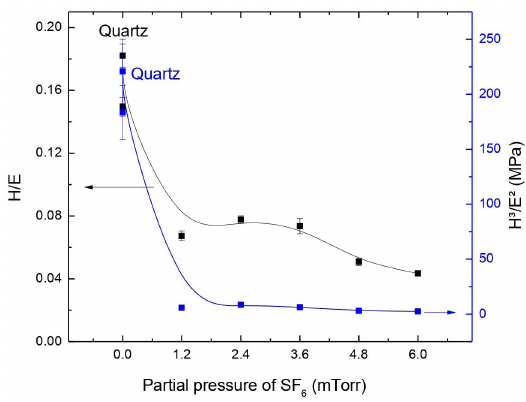
Figure 16. H/E and H 3 /E 2 as a function of R